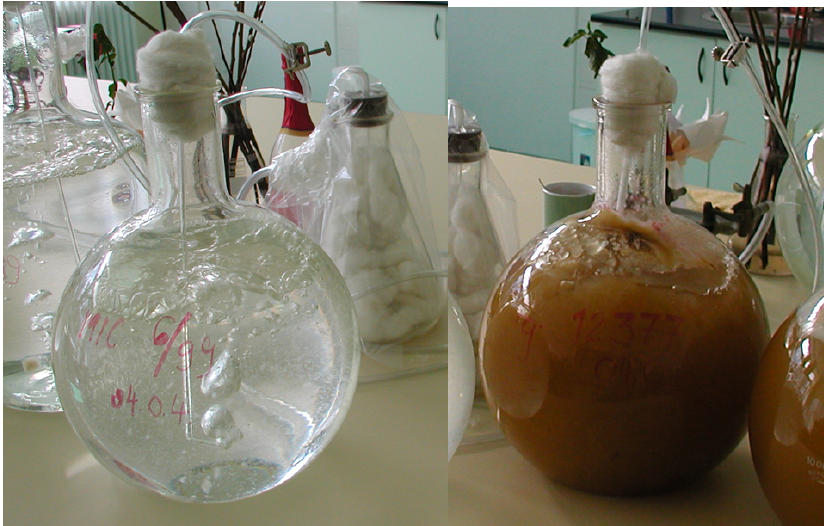
Figure 2. Bubble breeding method with Czapek-Dox medium, ( left ): two days old inoculum with a number of small mycelium fragments, ( right ): on the 7th day the inoculum is ready. The sterile air mixes the medium and secures oxygen support.